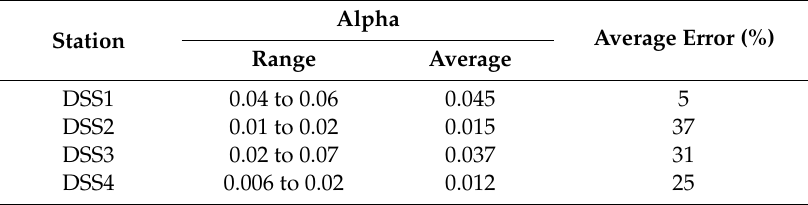
Table 5. Alpha values and associated error for each